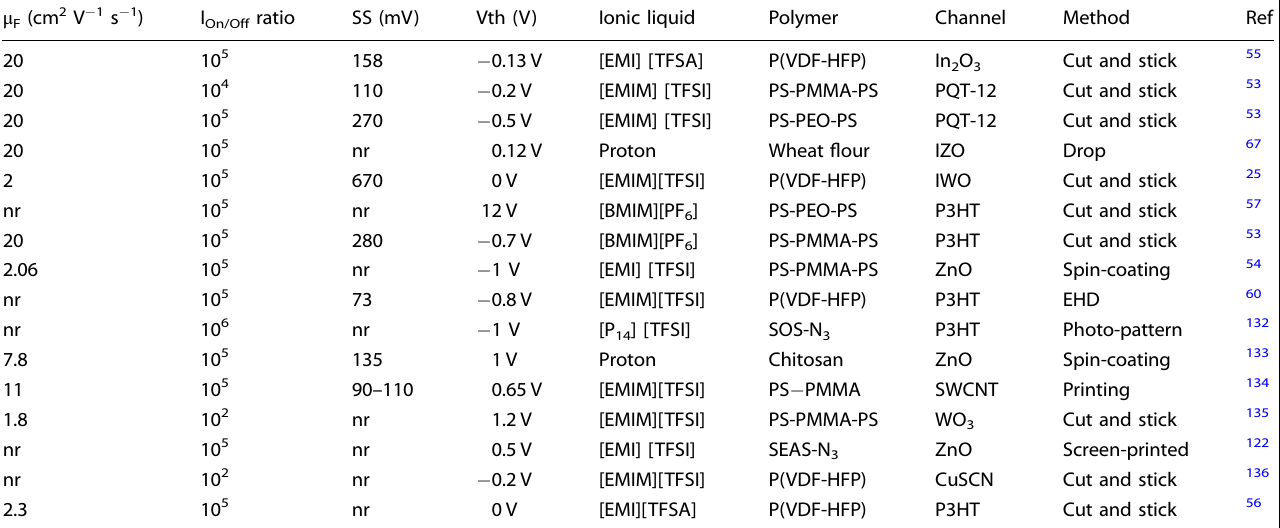
Table 1. Parameters comparison of Ionic-gel Gate